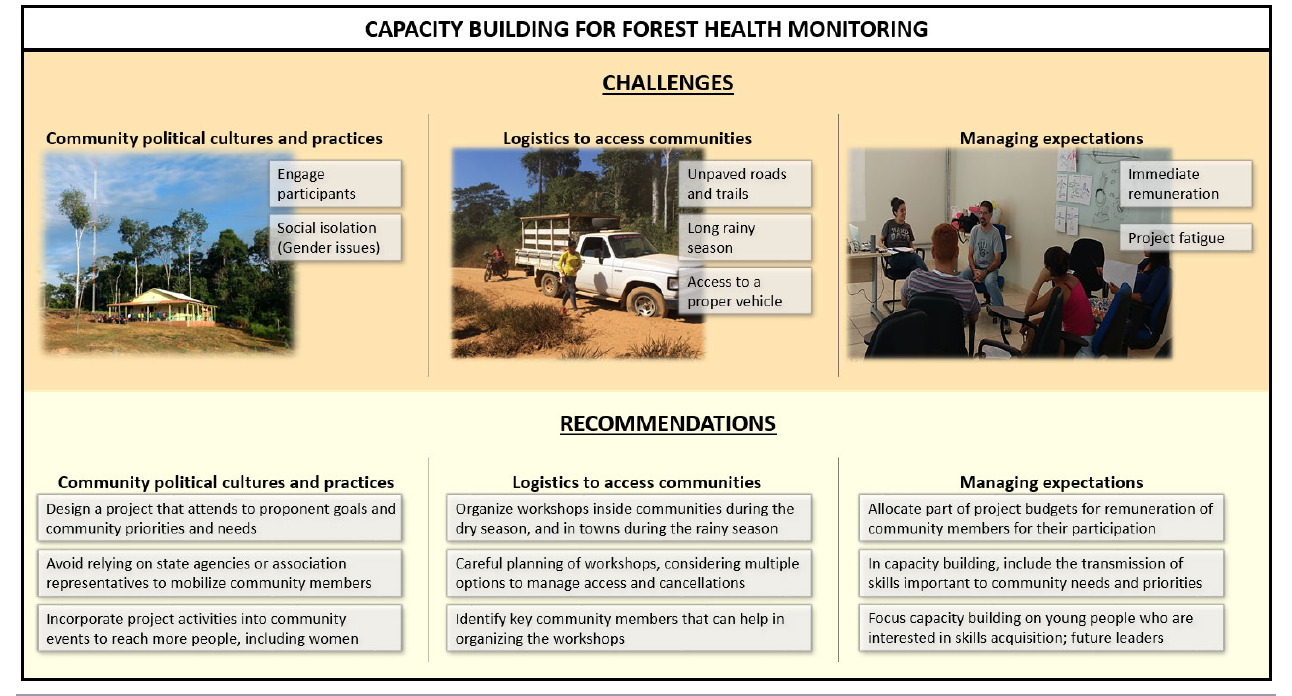
Fig. 2 . Challenges and recommendations for engaging rural communities in conservation and development